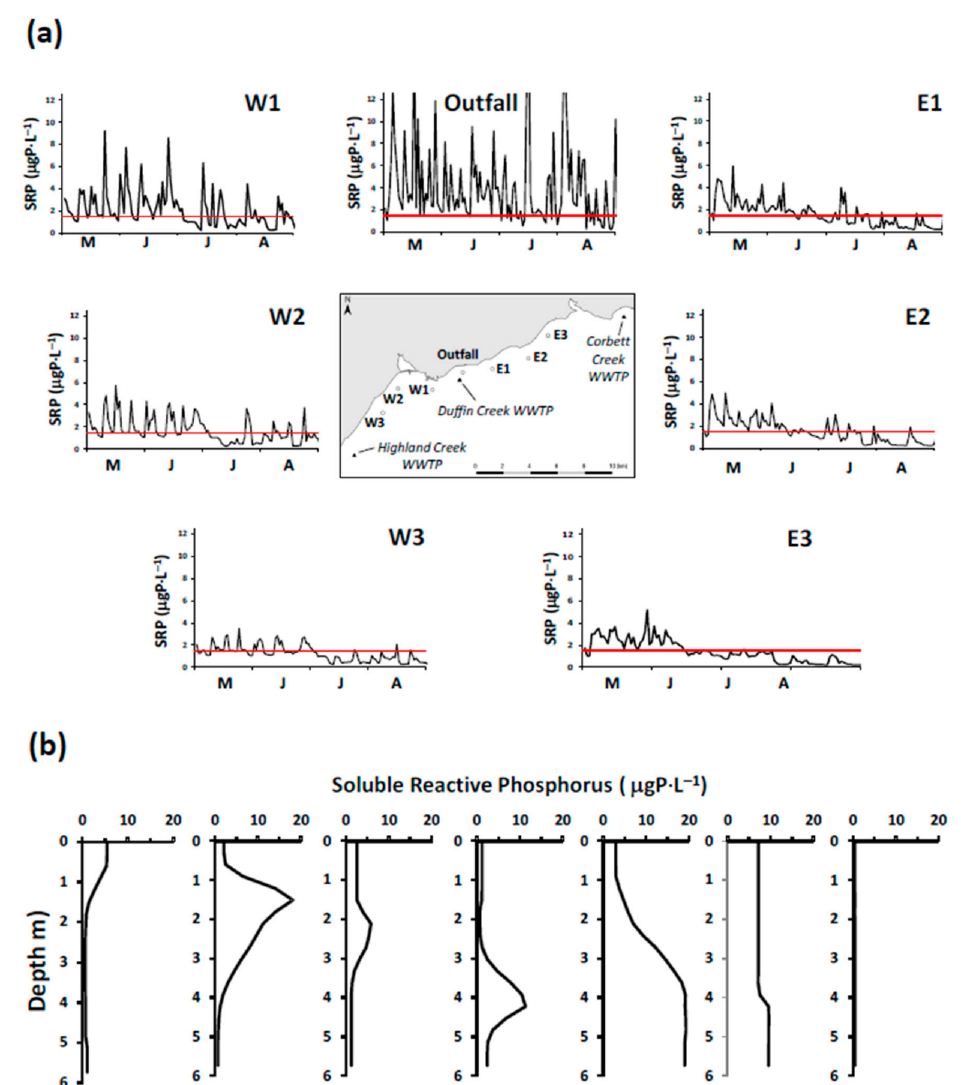
Figure 11. Model-simulated SRP concentrations with the Duffin Creek WWTP as a sole-source discharge at contemporary levels of phosphorus removal and flow: ( a ) for bottom water at a station proximate to the wastewater treatment plant (WWTP) outfall and at stations to the east and west. Station depths are >5 and <10 m; the red line represents the metric for P-limited growth (1.5 µ gP · L − 1 ) and ( b ) vertical profiles at the station most proximate to the Duffin Creek WWTP outfall. Profiles presented left to right are not a progressive time series, but are ordered to systematically illustrate variability in the position and magnitude of the plume as mediated by the vertical density gradient and